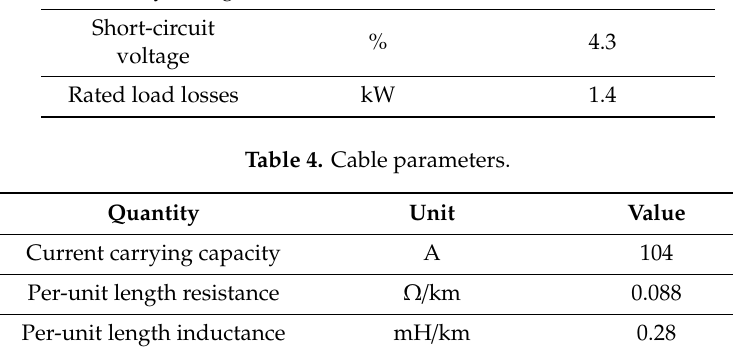
Table 4. Cable parameters.